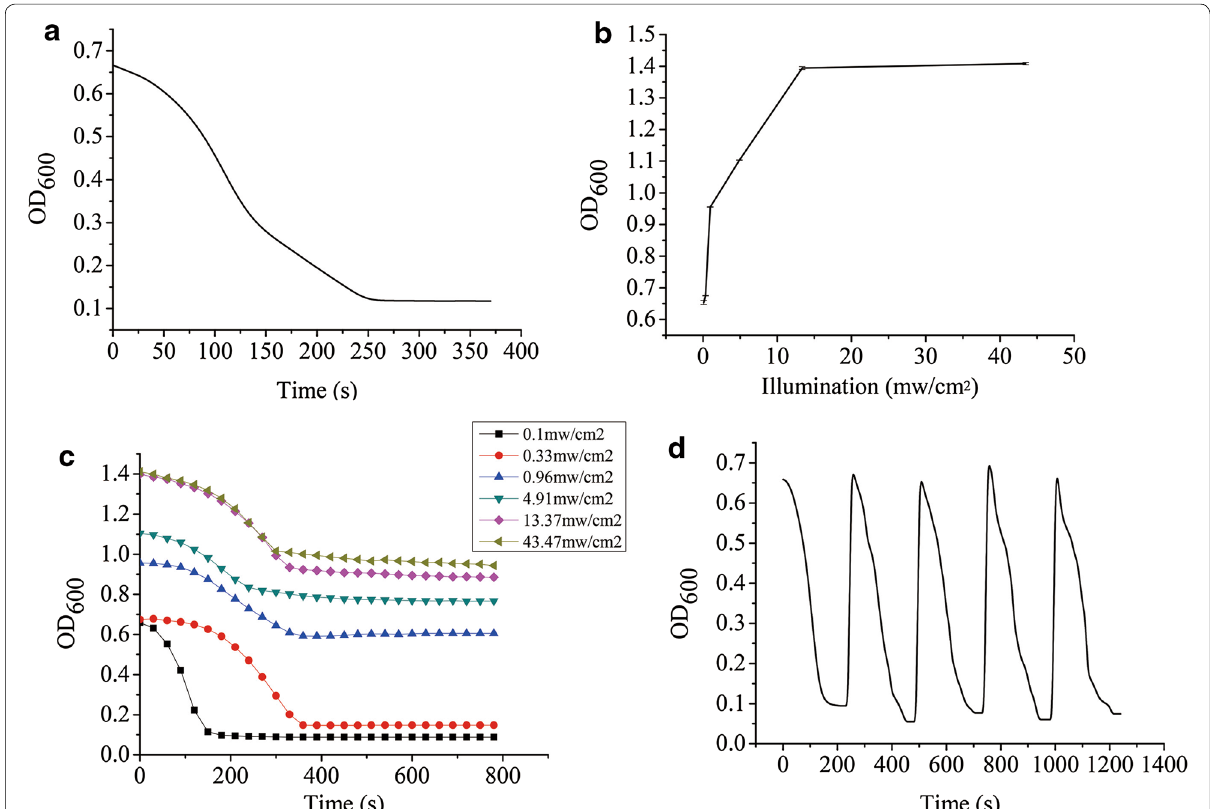
Fig. 4 Characterization of the light-controlled reversible assembly and disassembly of the BNAS in vitro by measuring the optical density at 600 nm and the nitrilase activity of BNASS. a Changes in OD 600 values with the disassembly of the BNASS complex. b Changes in OD 600 values under dif- ferent blue light intensities during photopolymerization. c Different degrees of disassembly of the polymer incubated under dark conditions after illumination at different intensities. d Light-induced reversible assembly and disassembly of the BNASS complex. The reactions were carried out in an ice bath. Error bars represent the standard error of three replicates